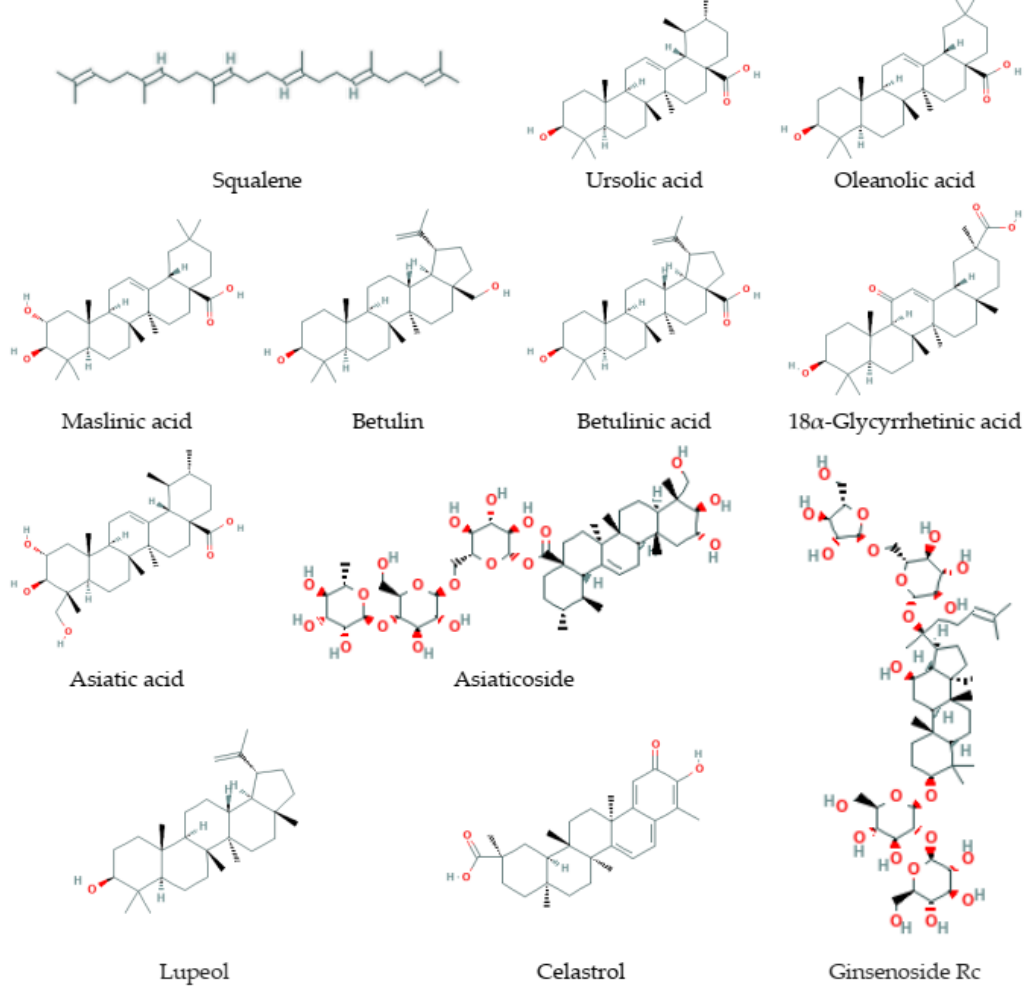
Figure 4. Some triterpenes that increase lifespan and delay age-related diseases.